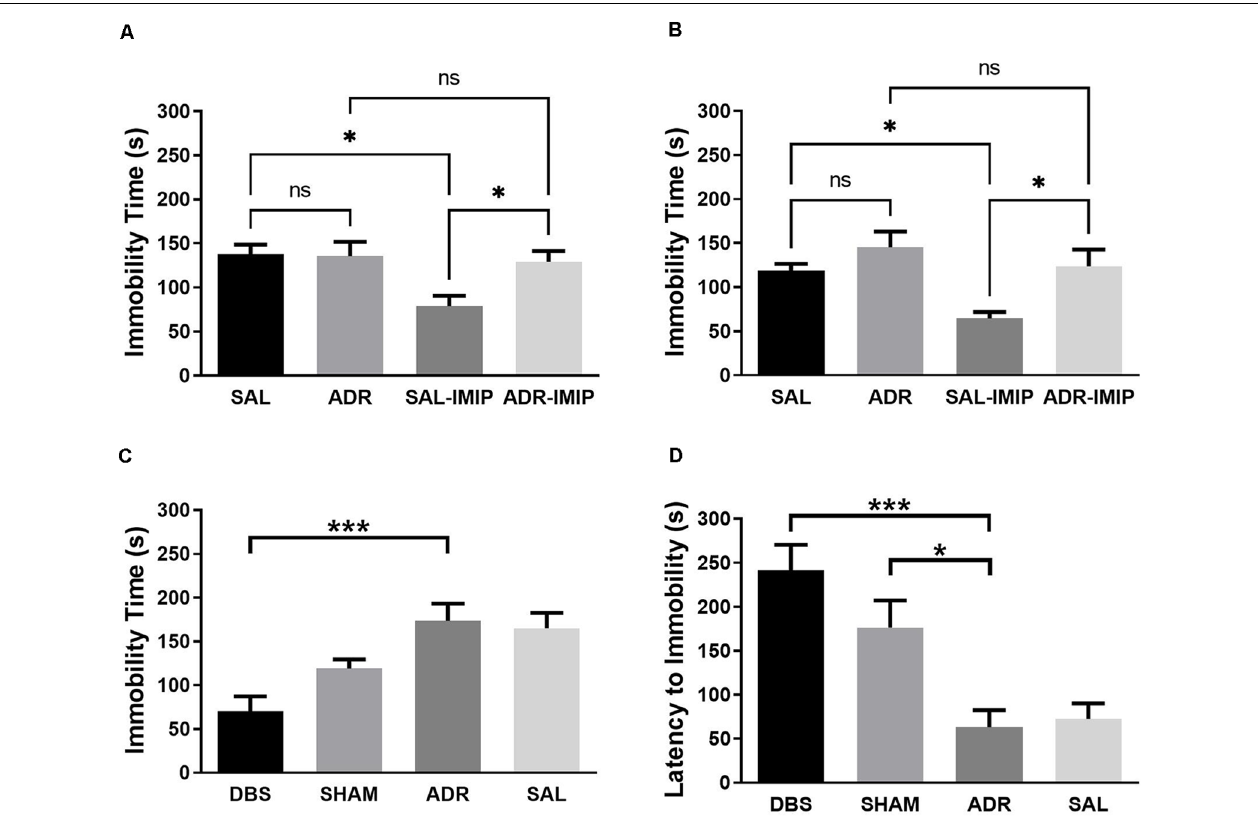
FIGURE 3 | Forced swim test total immobility time when antidepressant resistant (ADR) and saline control (SAL) animals are treated with imipramine (IMIP) at (A) 7 days and (B) 16 days into the ACTH treatment protocol, demonstrating validity of the ADR phenotype; and (C) immobility and (D) latency to first immobility following DBS or SHAM treatment. Data shown in mean seconds standard error. Significance is illustrated as * p < 0.05; *** p < 0.001; ns, not significant.